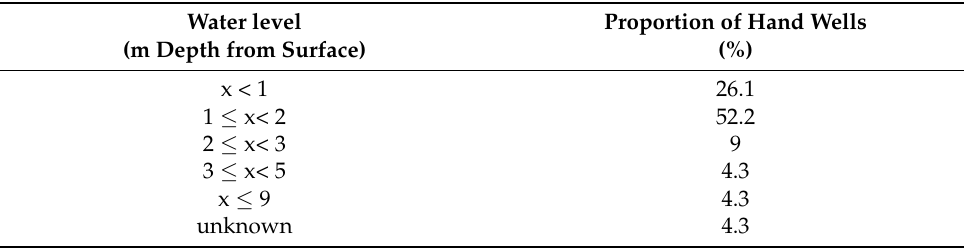
Table 1. Water levels in all surveyed hand wells.